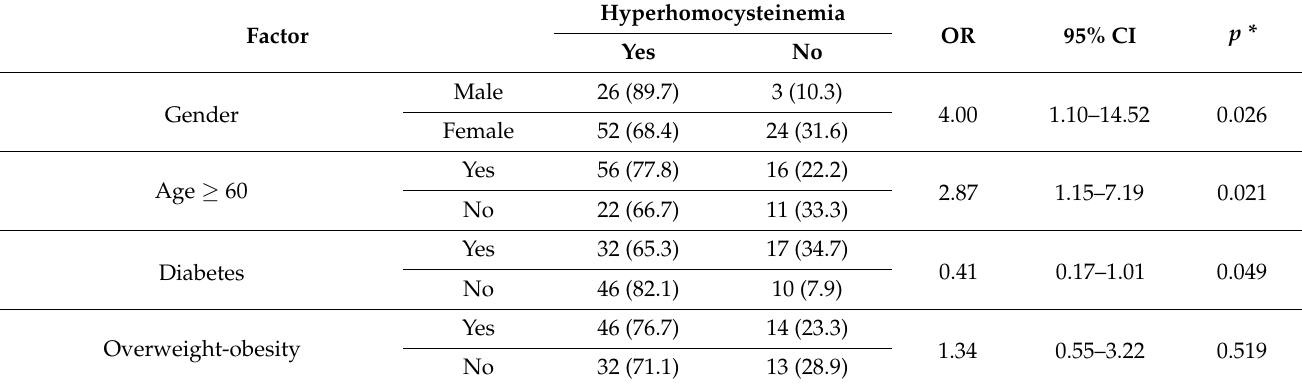
Table 2. The relationship between some risk factors and